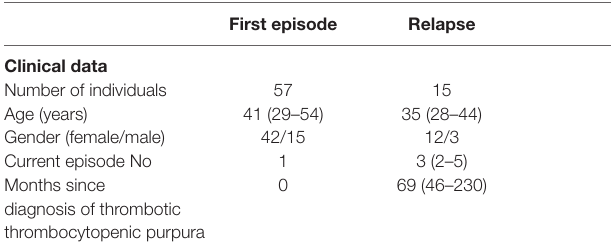
TaBle 1 | Comparison of levels and subclass distribution of anti-ADAMTS13 IgG antibodies between the first acute episode and relapse.